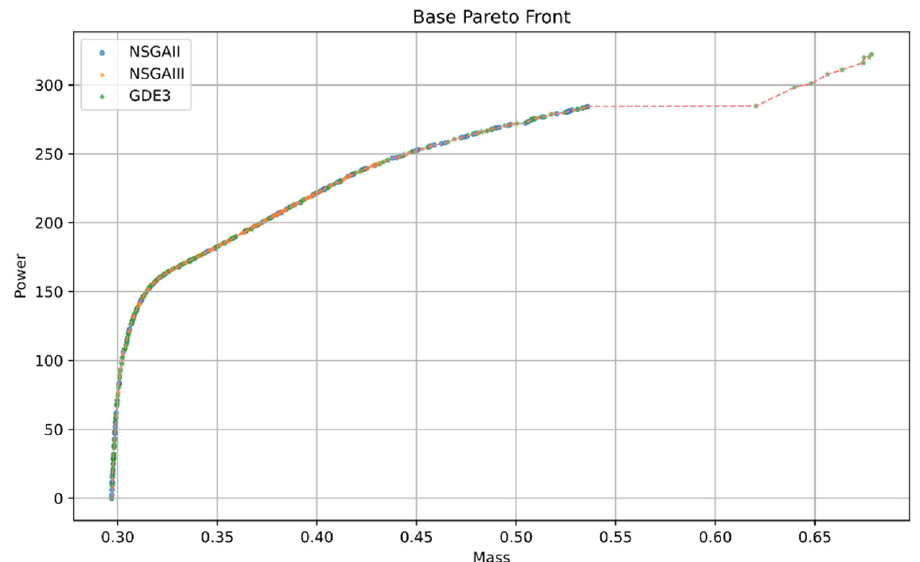
Figure 4. Base Pareto Front (BPF)—constructed from 10 runs of each algorithm (NSGA-II, NSGA-III, GDE3).